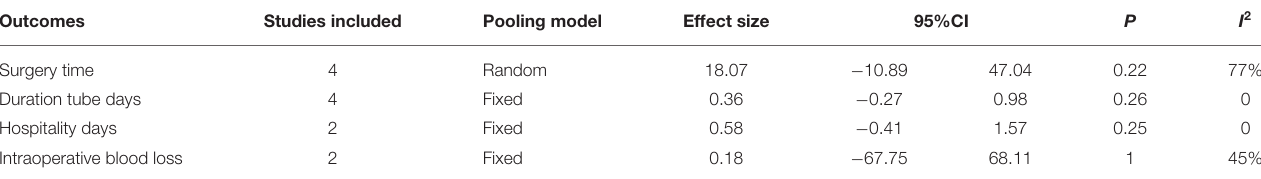
TABLE 3 | Secondary outcome measurements. Outcomes Studies included Surgery